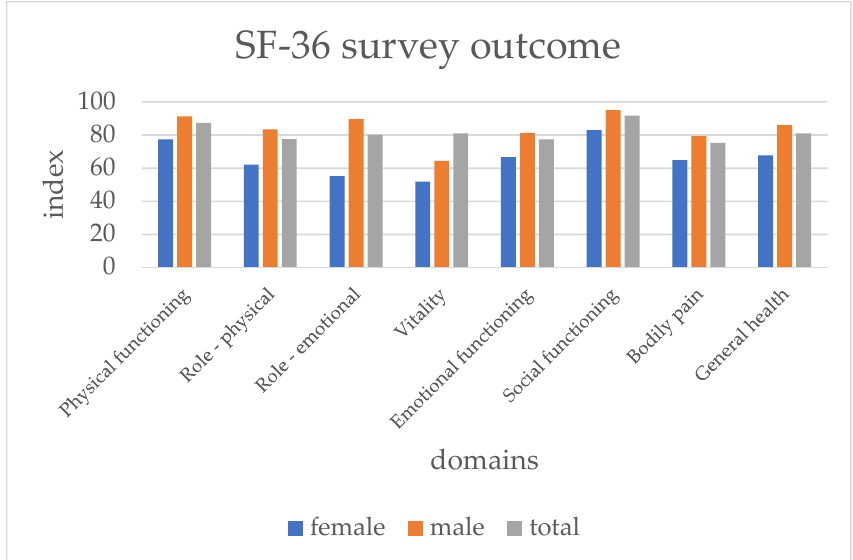
Figure 3. Mean of SF-36 domains by gender. Table 4. Survey outcome of SF-36 domains.